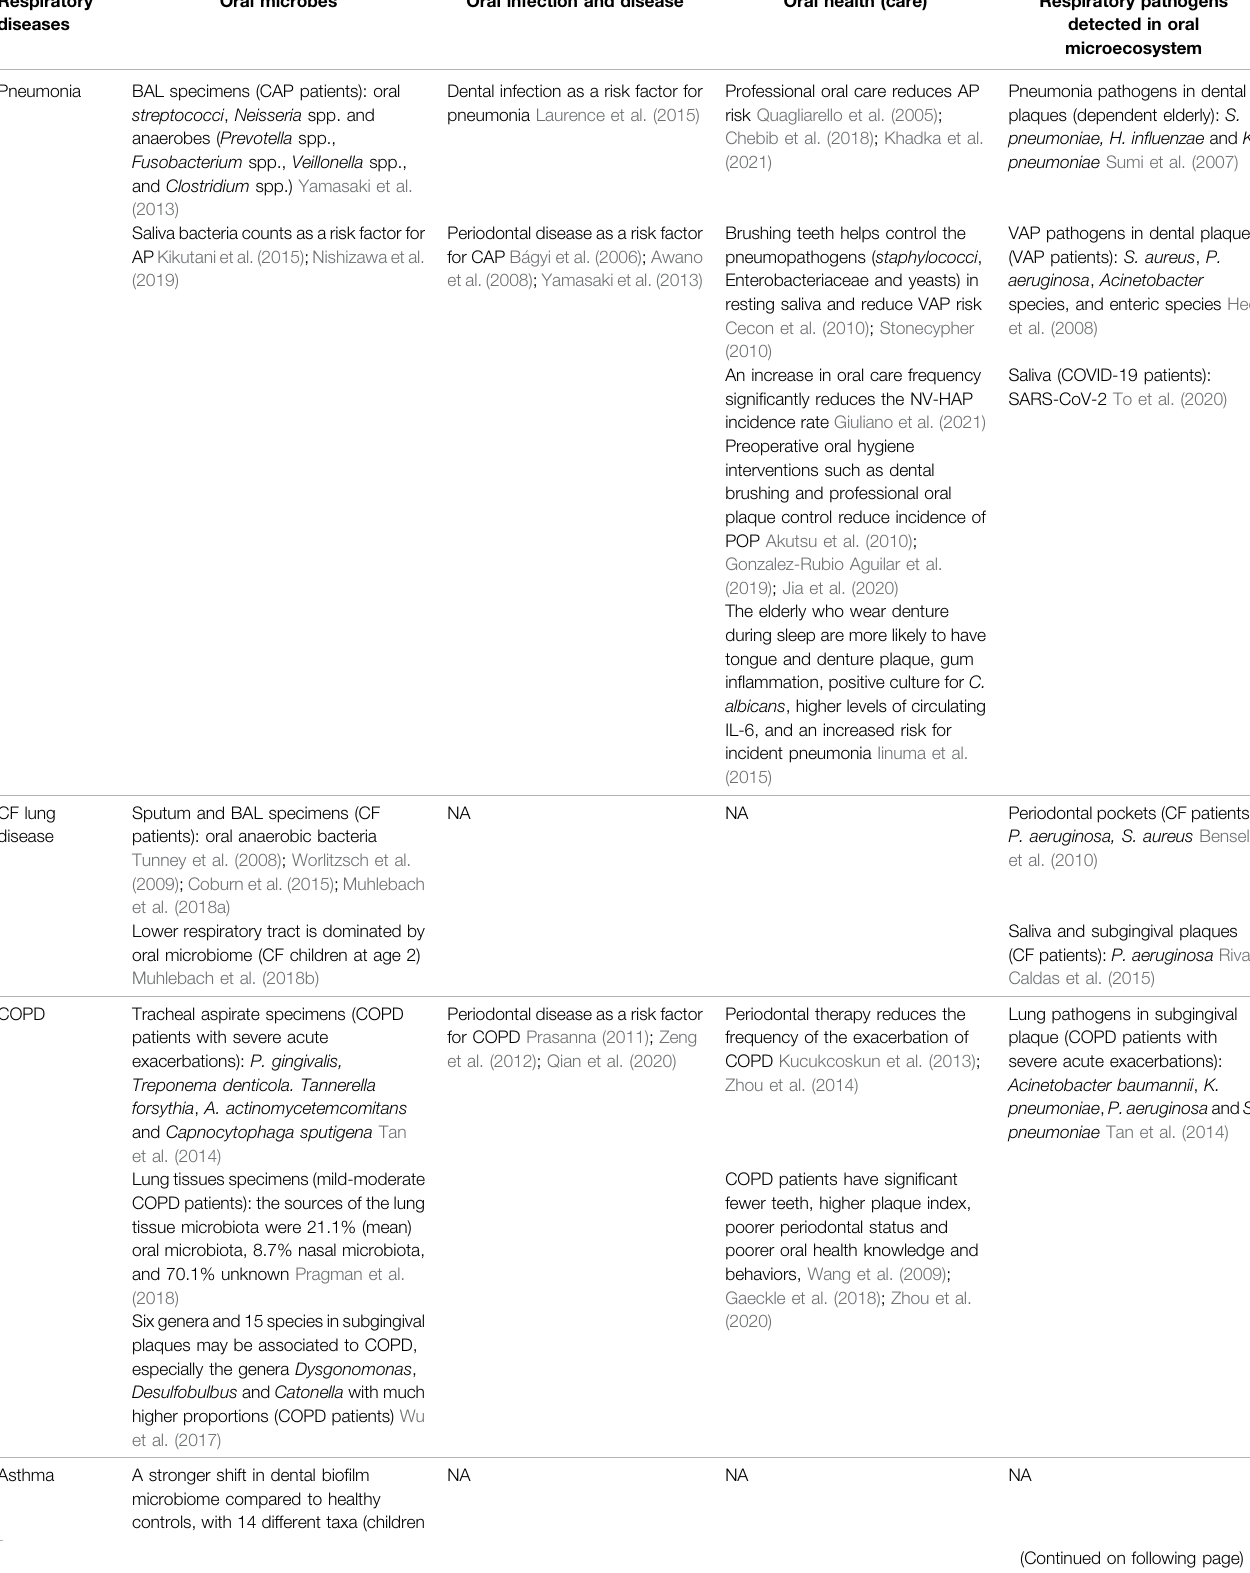
TABLE 1 | The relationship of oral microbes, oral infection and disease, oral health (care) with respiratory diseases. Respiratory